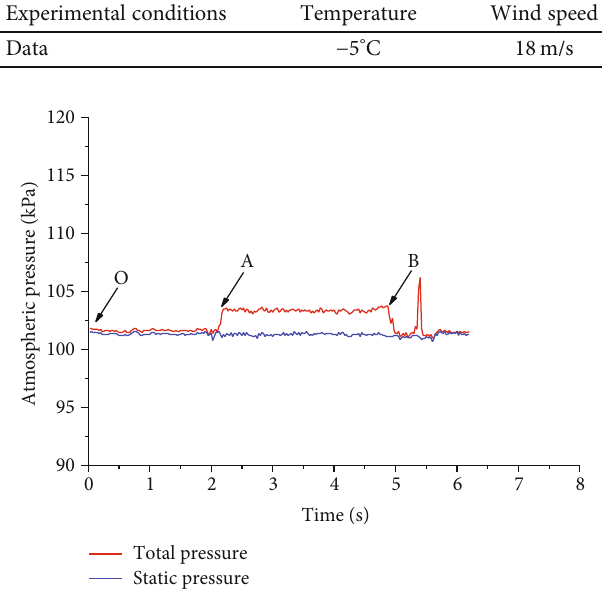
Figure 9: Total and static pressure outputs of the pitot tube after blocking by non-ice materials. O – A: the entire air pressure detection system is stationary. A – B: the L-shaped pitot tube is placed into the ice wind tunnel at point A such that the total pressure hole is facing the incoming wind direction. After B: the rubber sleeve is installed on the total pressure hole of the pitot tube at point B. Table 5: Parameters of the normal temperature